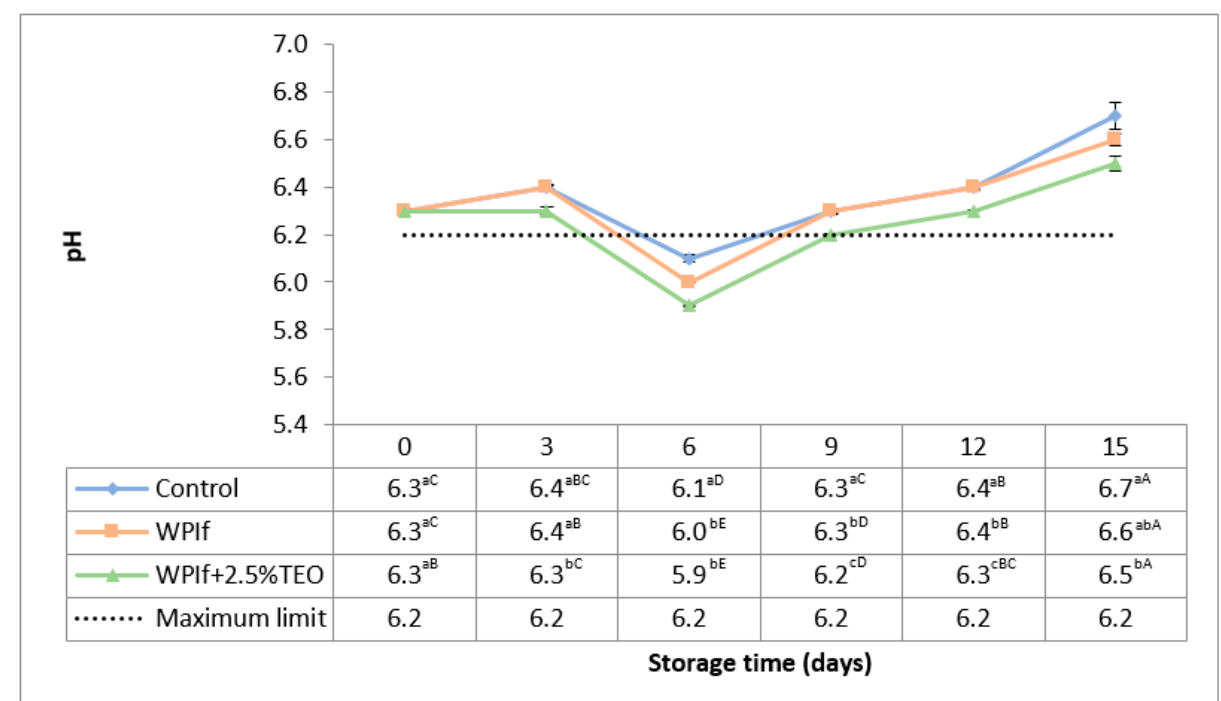
Figure 1. Changes in pH of brook trout samples during refrigerated storage. Control-uncovered fish samples; WPIf-fish samples covered with WPI-based films; WPIf+2.5%TEO-fish samples covered with whey protein isolate-based films incorporated with 2.5% tarragon essential oil. Values are expressed as mean ± standard deviation of two replicates. Means that do not share a letter (lowercase letters on column and uppercase letters on row) are significantly different.